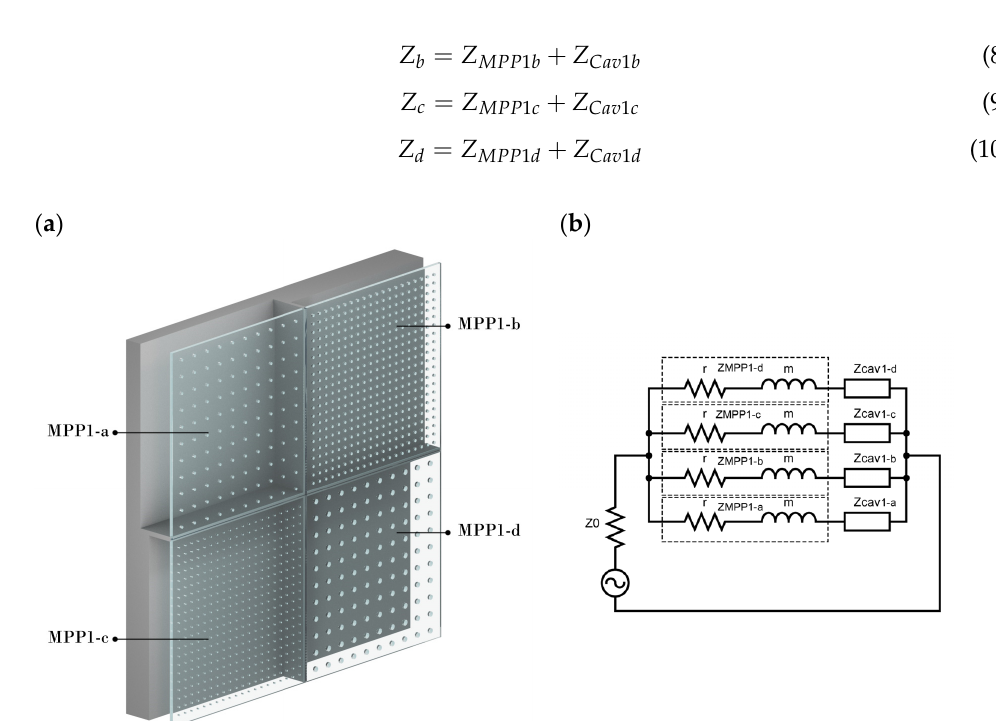
Figure 2. ( a ) A schematic diagram of four parallel-arranged MPPs with partitioned cavities and ( b ) its respective equivalent circuit.